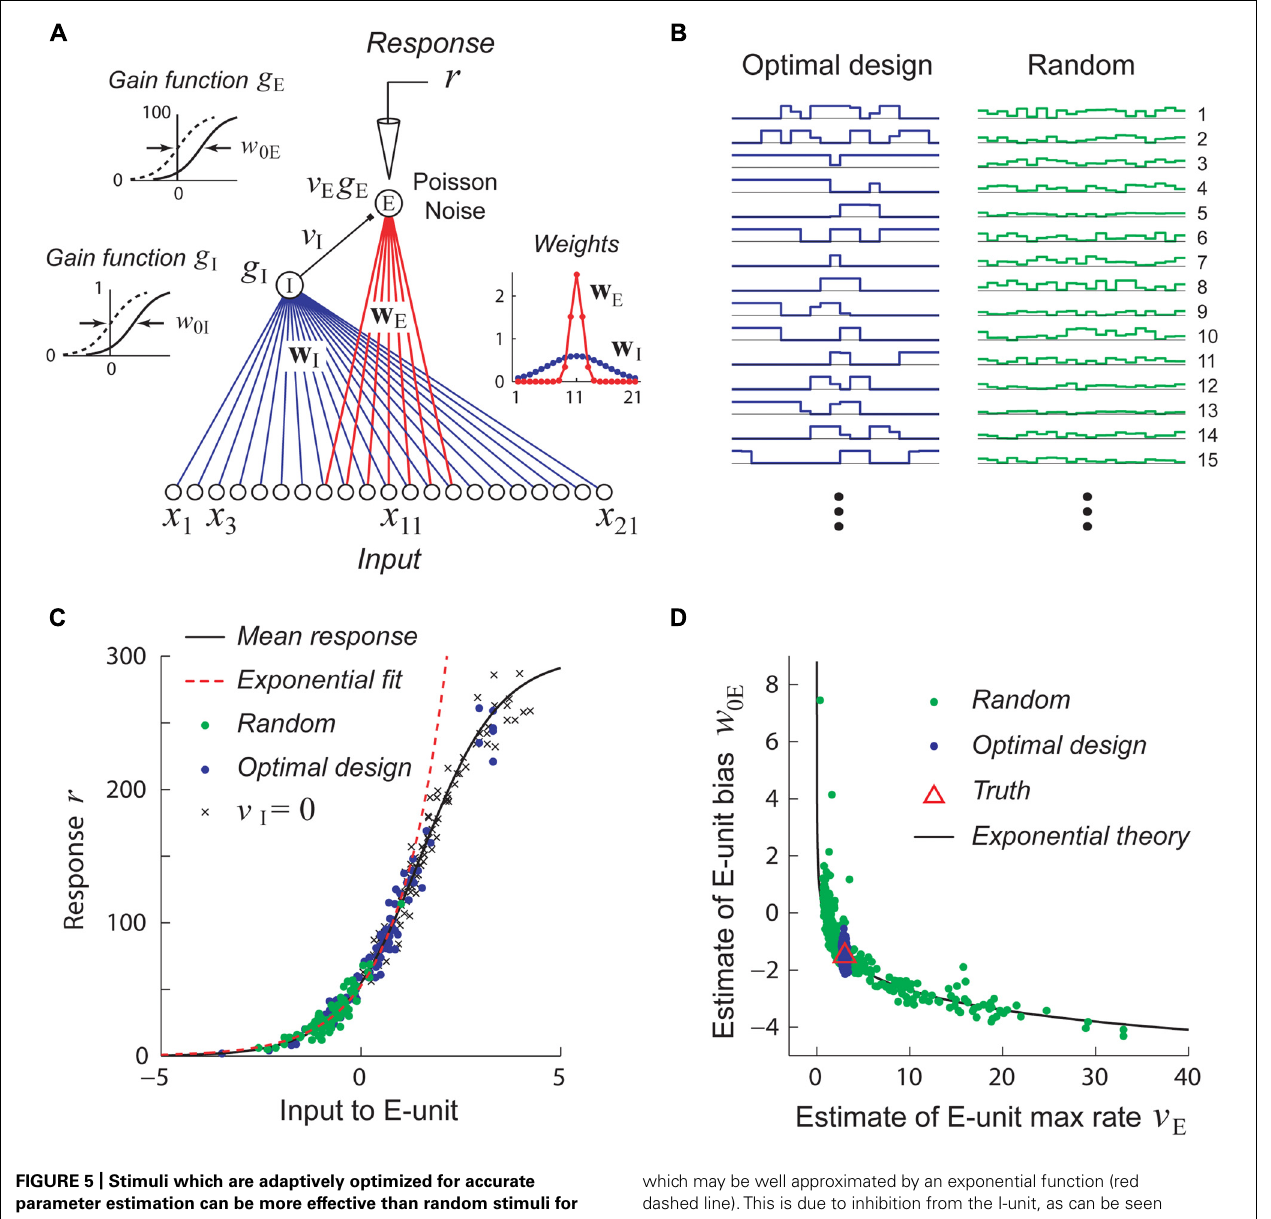
FIGURE 5 | Stimuli which are adaptively optimized for accurate parameter estimation can be more effective than random stimuli for recovering non-linear models. Adapted with permission from DiMattina and Zhang (2011). (A) A simple center-surround neural network consisting of a narrowly integrating excitatory output unit (E-unit) which receives inhibitory input from a broadly integrating interneuron (I-unit). (B) Examples of optimally designed (left) and random (right) stimuli. Note that the optimally designed stimuli exhibit complex correlated structure. (C) Random stimuli (green dots) only drive the E-unit over a limited range of its gain function (black curve)